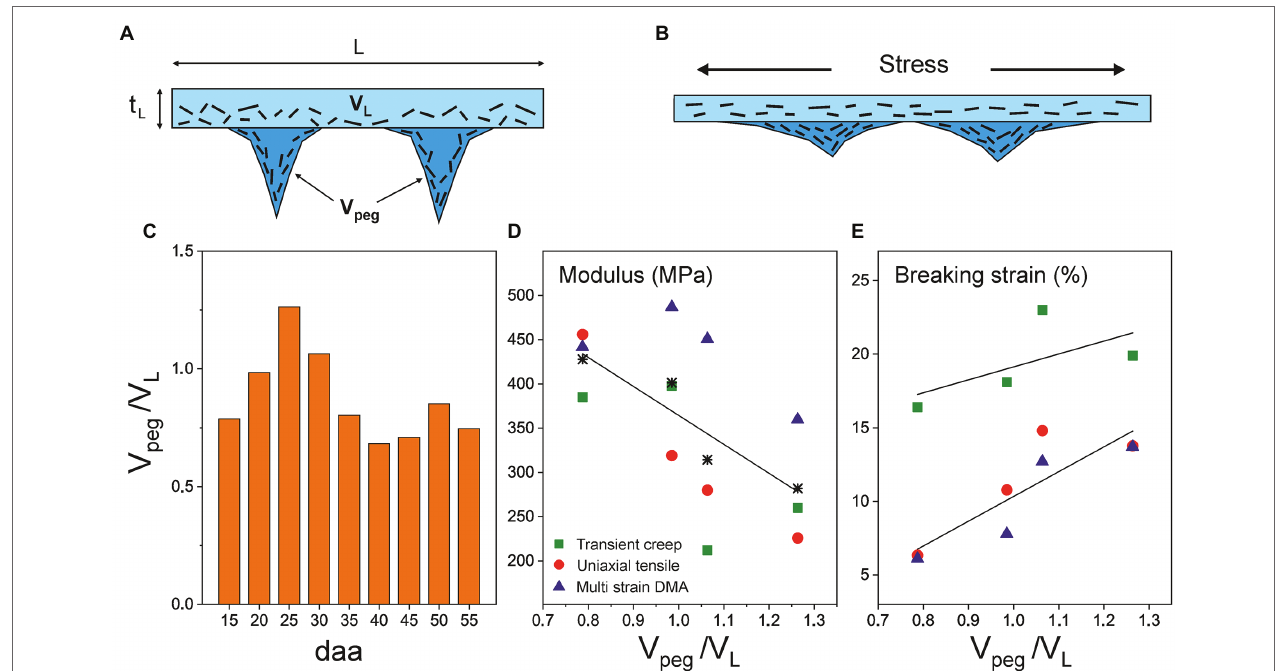
FIGURE 8 | (A) Schematic representation of a cross-section of isolated tomato Cascada cuticles and (B) under an applied stress. (C) Evolution of V peg /V L (invagination) along ripening. Correlation between the invagination degree and (D) the Young’s modulus and (E) the breaking strain in the softening stage (15–30 daa) of tomato Cascada cuticles. Asterisks in (D) are the modulus average